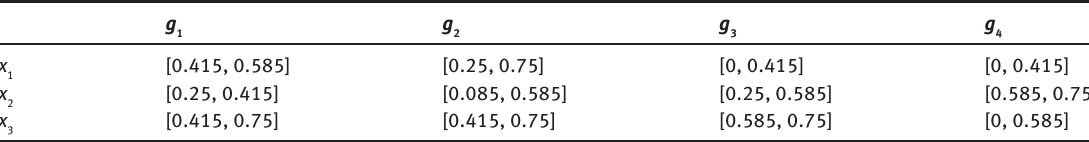
Table 8: The 0.5-Cut Operation